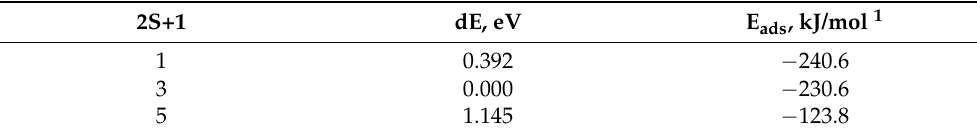
Table 7. Relative energies of Pt 4 *C 6 H 6 and the energy of BZ adsorption on Pt 4 for different states.